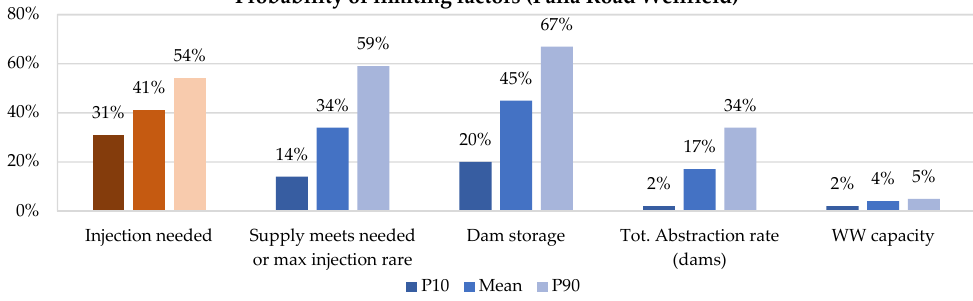
Figure 7. Expected probability of annual water shortages of different magnitudes in Great Gaborone for each year in Scenario C, including Masama/Makhujwane and Palla Road/Chepete, MAR.